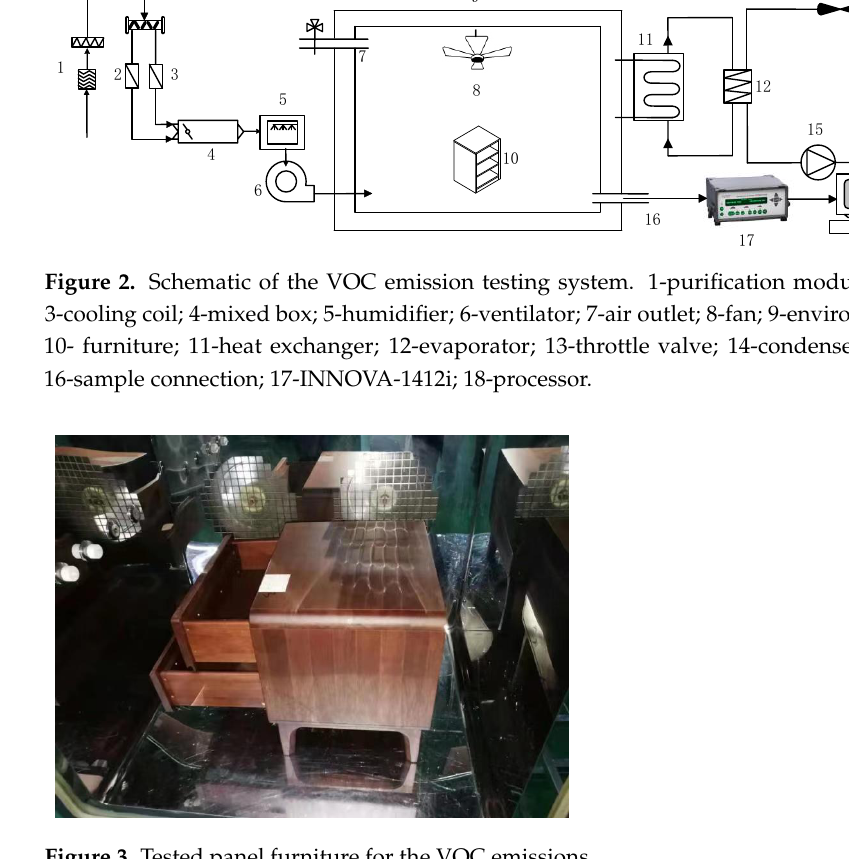
Figure 3. Tested panel furniture for the VOC emissions.